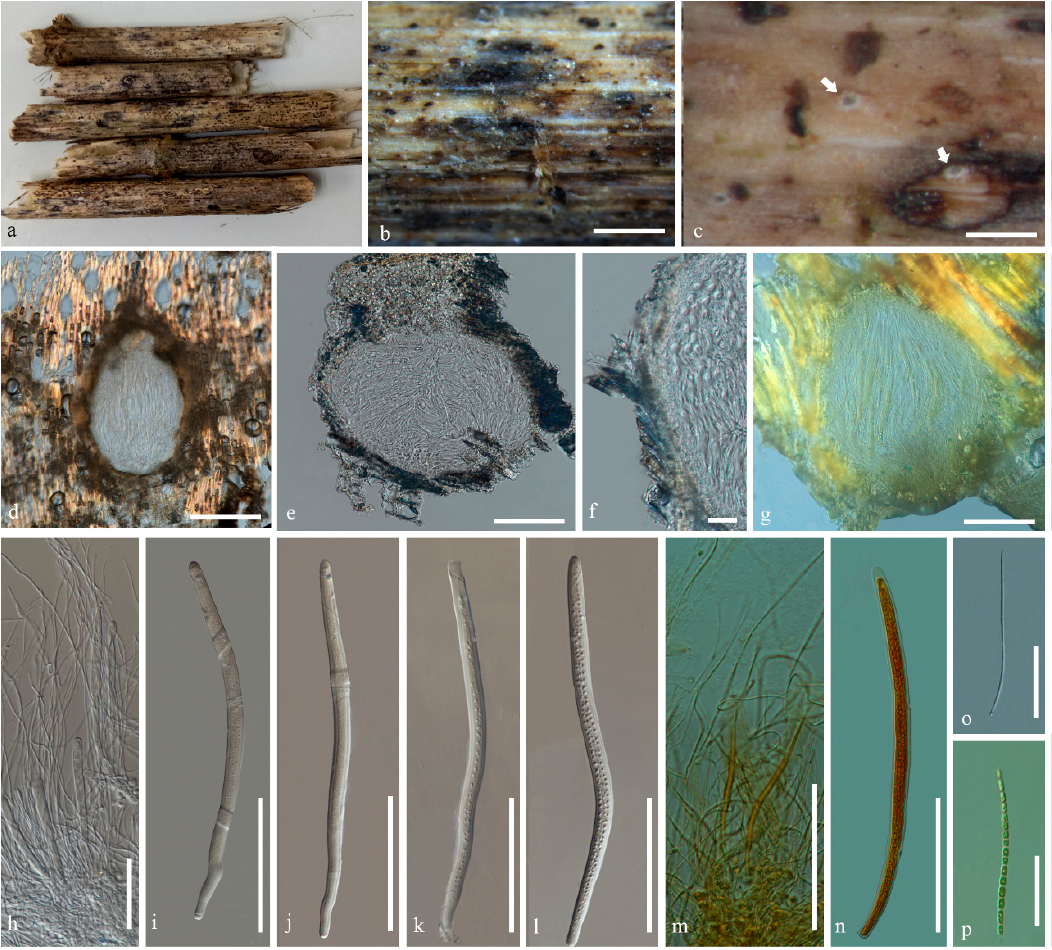
Figure 4. Ostropomyces pruinosellus (MFLU 20-0538). ( a – c ) Ascomata on substrate. ( d , e ) Vertical section through ascoma (in water). ( f ) Vertical section through exciple (in water). ( g ) Vertical section through ascoma (in KI). ( h ) Paraphyses (in water). ( i – l ) Asci (in water). ( m ) Paraphyses (in KI). ( n ) Asci (in KI). ( o ) Ascospores (in water). ( p ) Ascospores (in KI). Scale bars b, c = 1000 µm, d, e, g – n = 100 µm, f = 30 µm, o, p = 50 µm.